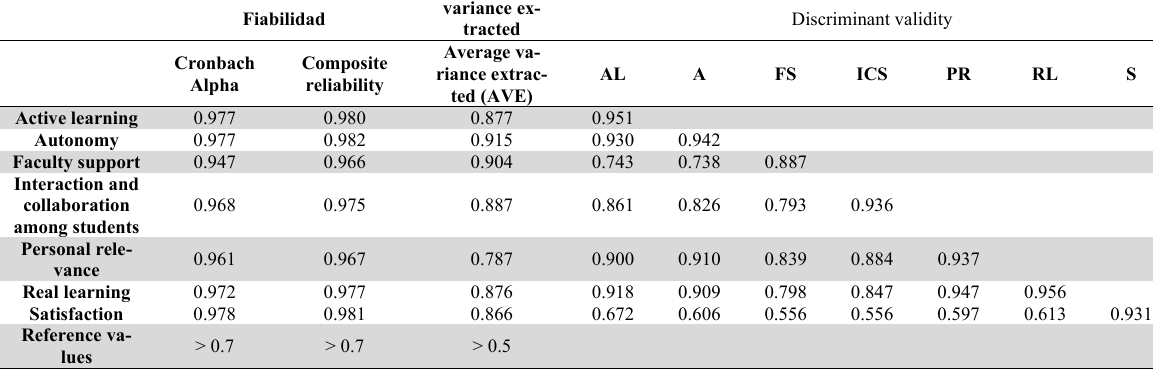
Test results for the measurement model